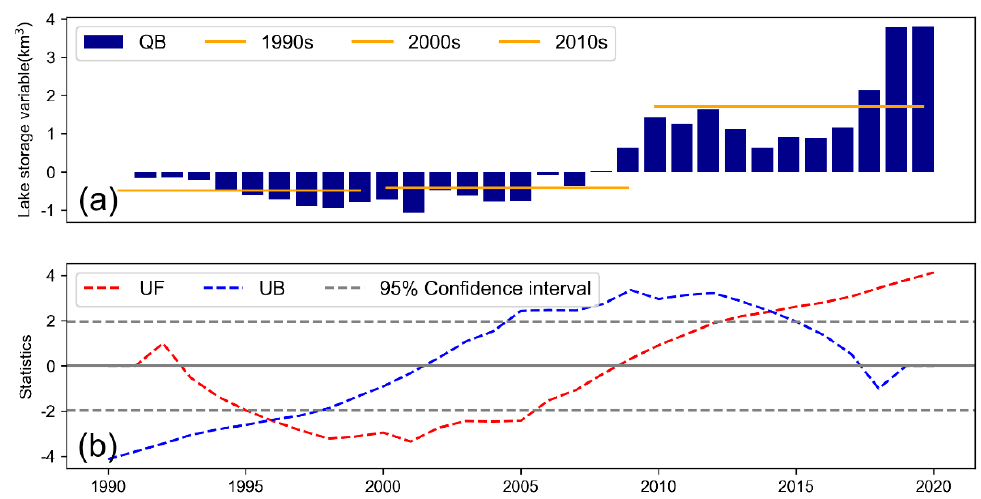
Figure 4. ( a ) The lake storage variable of Qaidam Basin from 1990 to 2020. The orange solid line represents the decade average of the change in lake storage variable. ( b ) Mann-Kendall test results of lake storage variable.